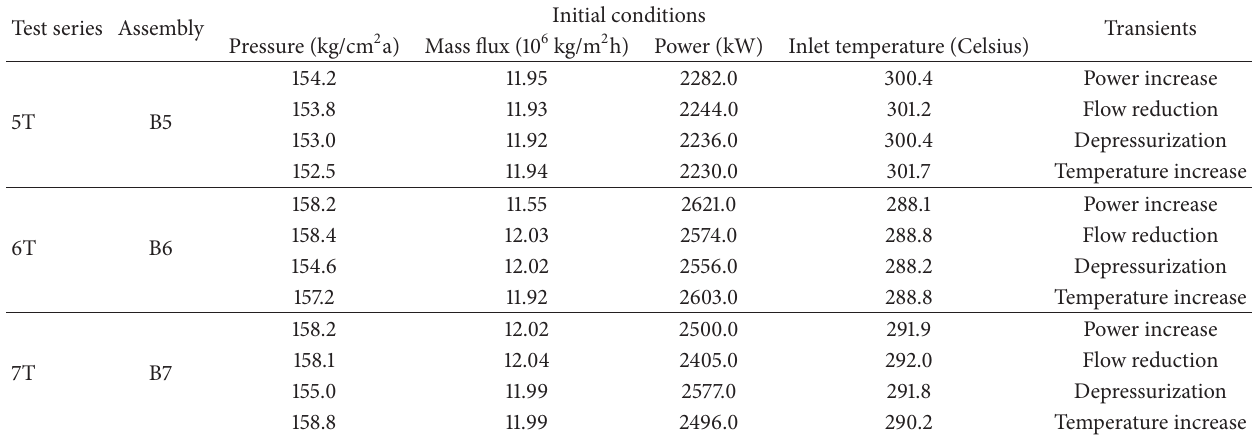
Table 8: Test conditions for transient void measurement test series 5T, 6T, and